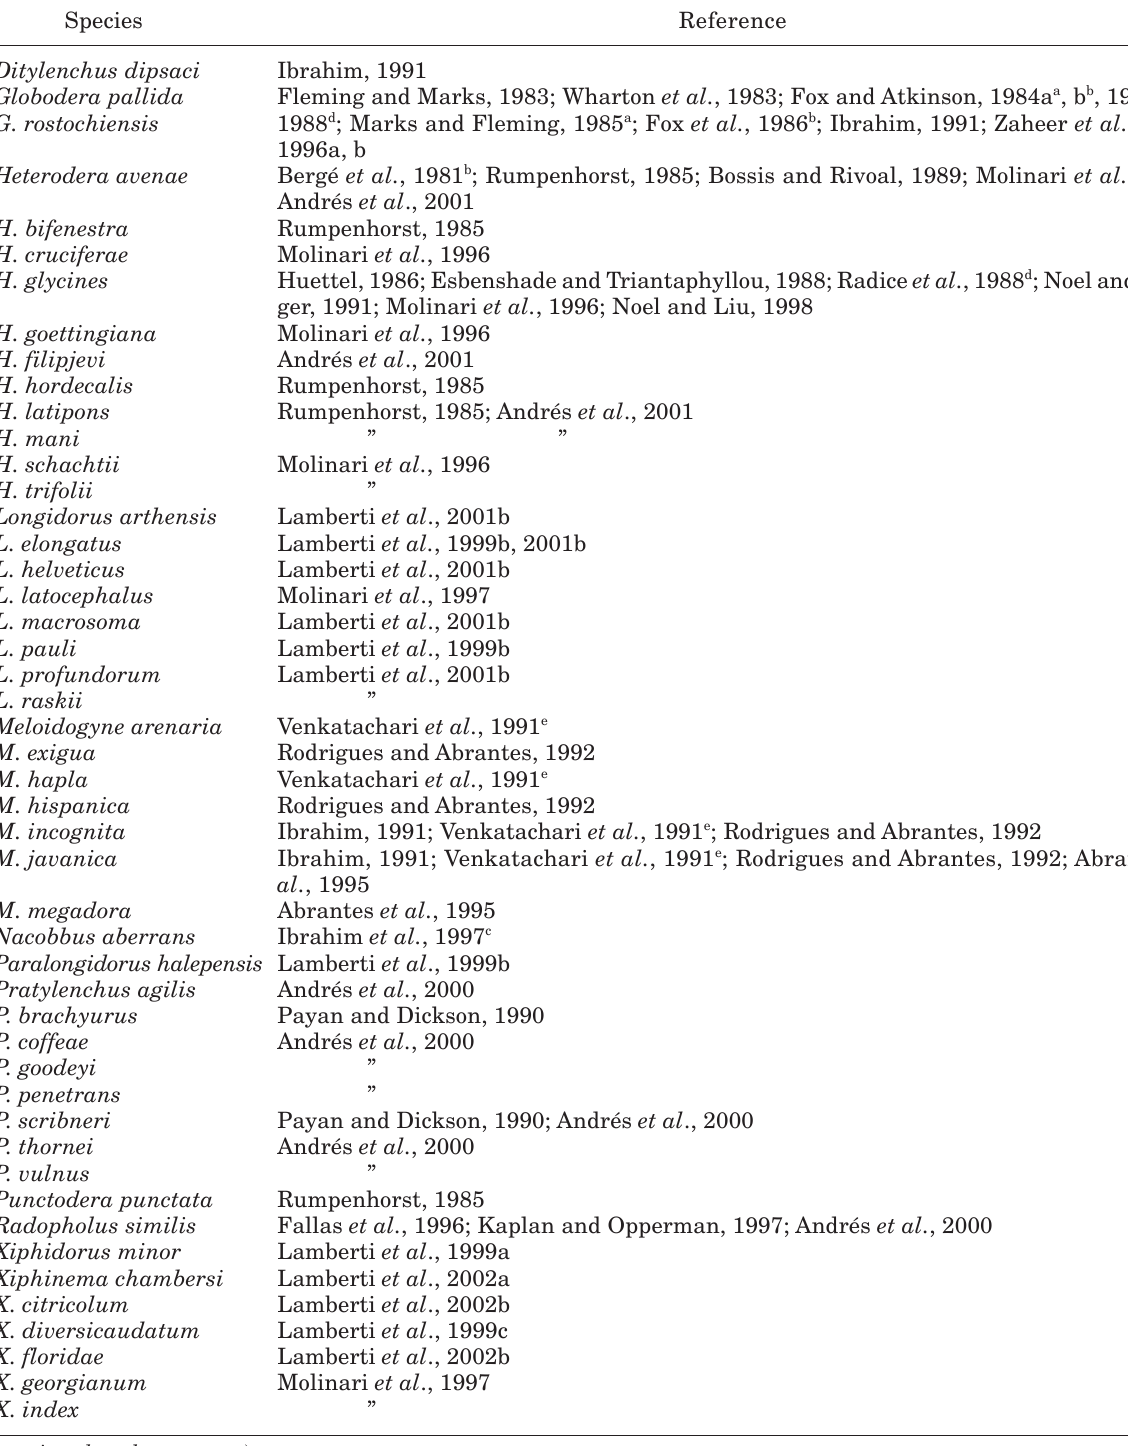
Table 6. Plant-parasitic nematodes species characterized on the basis of enzymes, using isoelectric focusing.